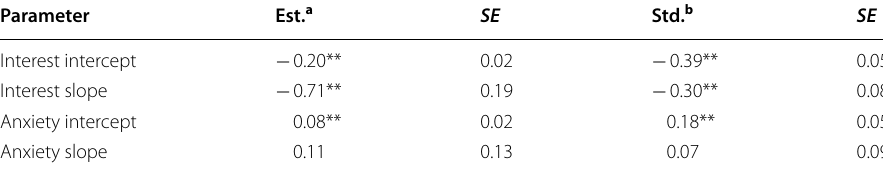
** p < .01 a Unstandardized estimates, b standardised estimates